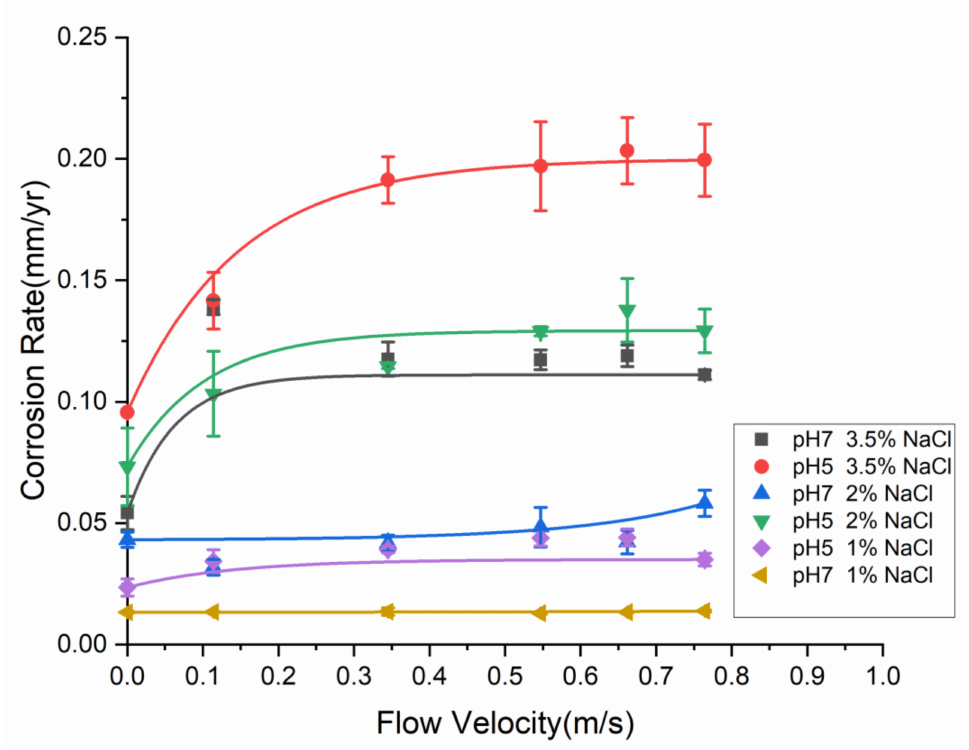
Figure 10. Corrosion rates of API-5L-X65 QT metal are shown at different flow velocities maintaining the feed solution pH of 5 and 7 and varying NaCl concentrations at 25 ◦